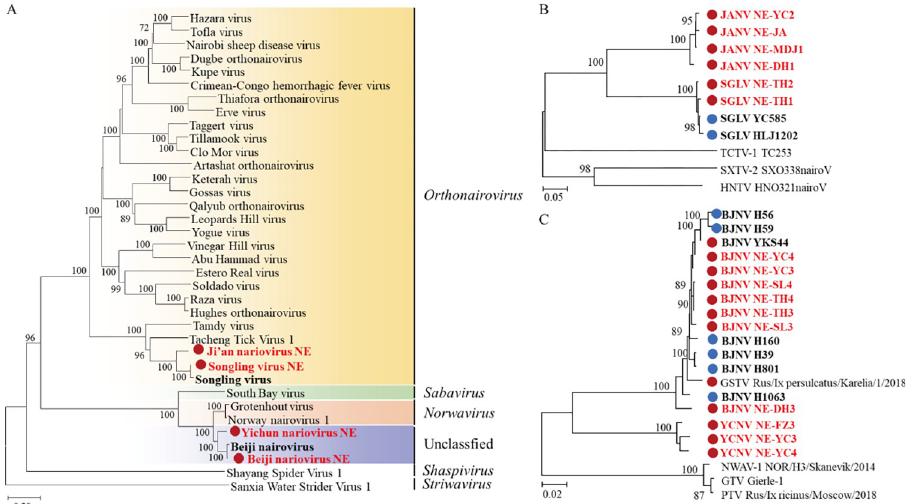
Fig 4. Phylogenetic analyses of nairoviruses. Phylogenetic trees were constructed based on the RdRp protein sequences of representative viruses in the Nairoviridae family (A), the S segment of JANV and SGLV (B), and the S segment of BJNV and YCNV (C). All the viruses obtained in ticks here were highlighted in red, and the closest referenced viruses were also highlighted in bold font. In panel B and C, viral strains identified in this study were marked with red-filled circles, while strains found in humans were marked with blue-filled circles. JANV, Ji’an nariovirus; SGLV, Songling virus; TCTV1, Tacheng tick virus 1; SXTV2, Shanxi tick virus 2; HNTV, Henan tick virus; YCNV, Yichun nariovirus; BJNV, Beiji nariovirus; GKTV, Gakugsa tick virus; PTV, Pustyn virus; NWNV1, Norway nairovirus 1; GTV, Grotenhout virus. The accession numbers of the viral sequences are shown in S2 and S3 Tables.